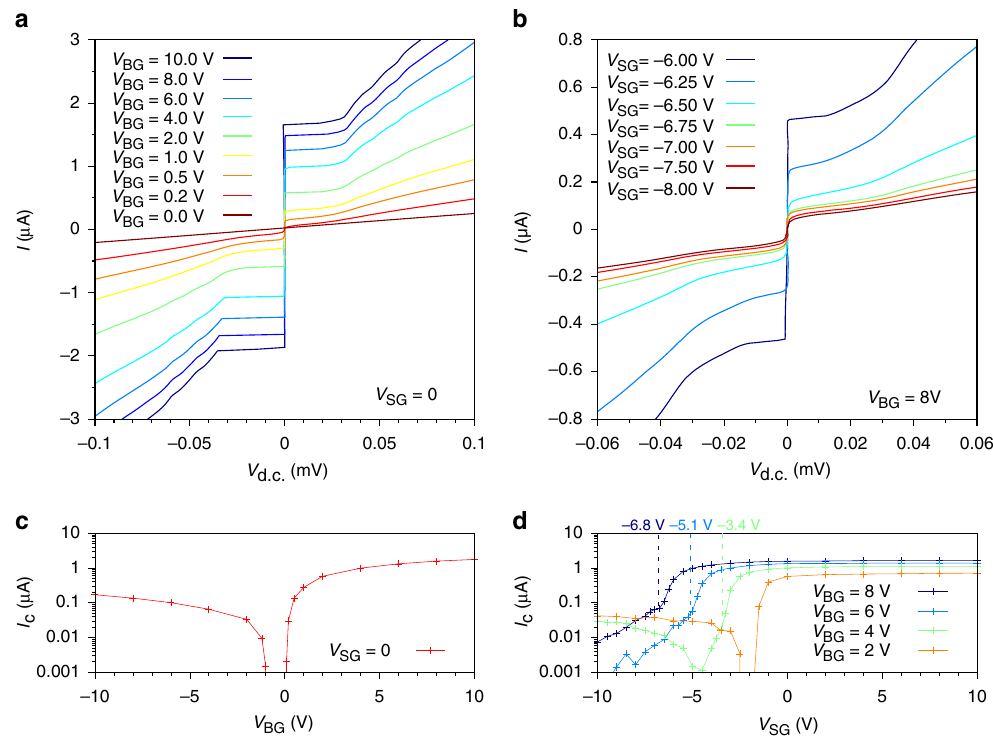
Fig. 3 Gate-controlled current in a superconducting BLG weak link. a I-V curves for different V BG , i.e., densities, characterising the 2D system at V SG = 0. b I-V curves at fi xed back-gate voltage V = 8 V for various displacement fi elds D in the dual-gated region, i.e., for split-gate voltages close to the transition BG from NNN to NP n N. c Back-gate voltage dependence V BG of the critical current I c . d I c ( V SG ) for constant charge carrier densities (i.e., constant V BG